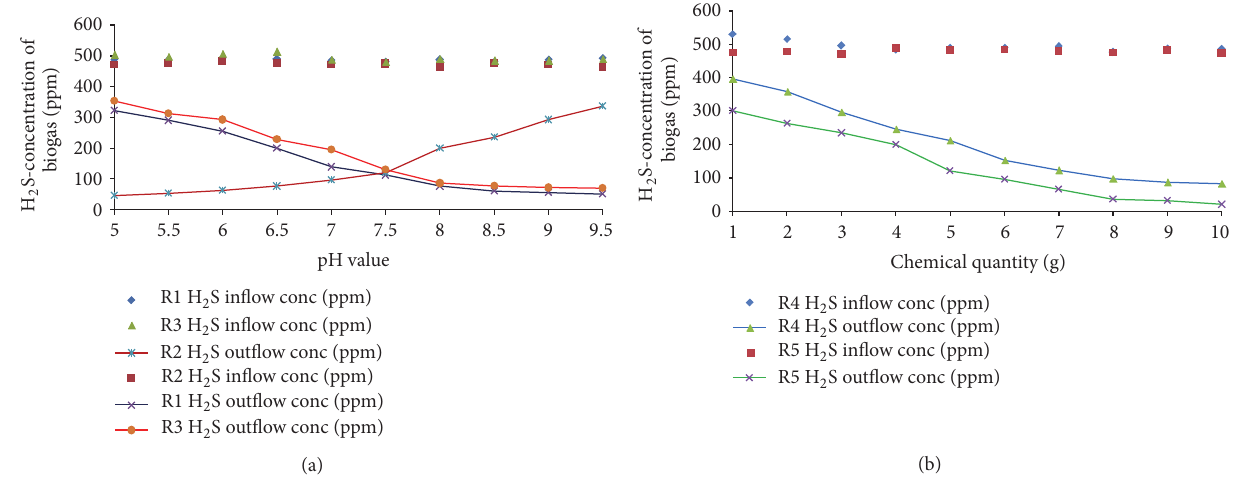
Figure 3: (a) H 2 S inflow versus outflow concentration of biogas under the treatments of runs R1, R2, and R3 and (b) for runs R4 and R5.